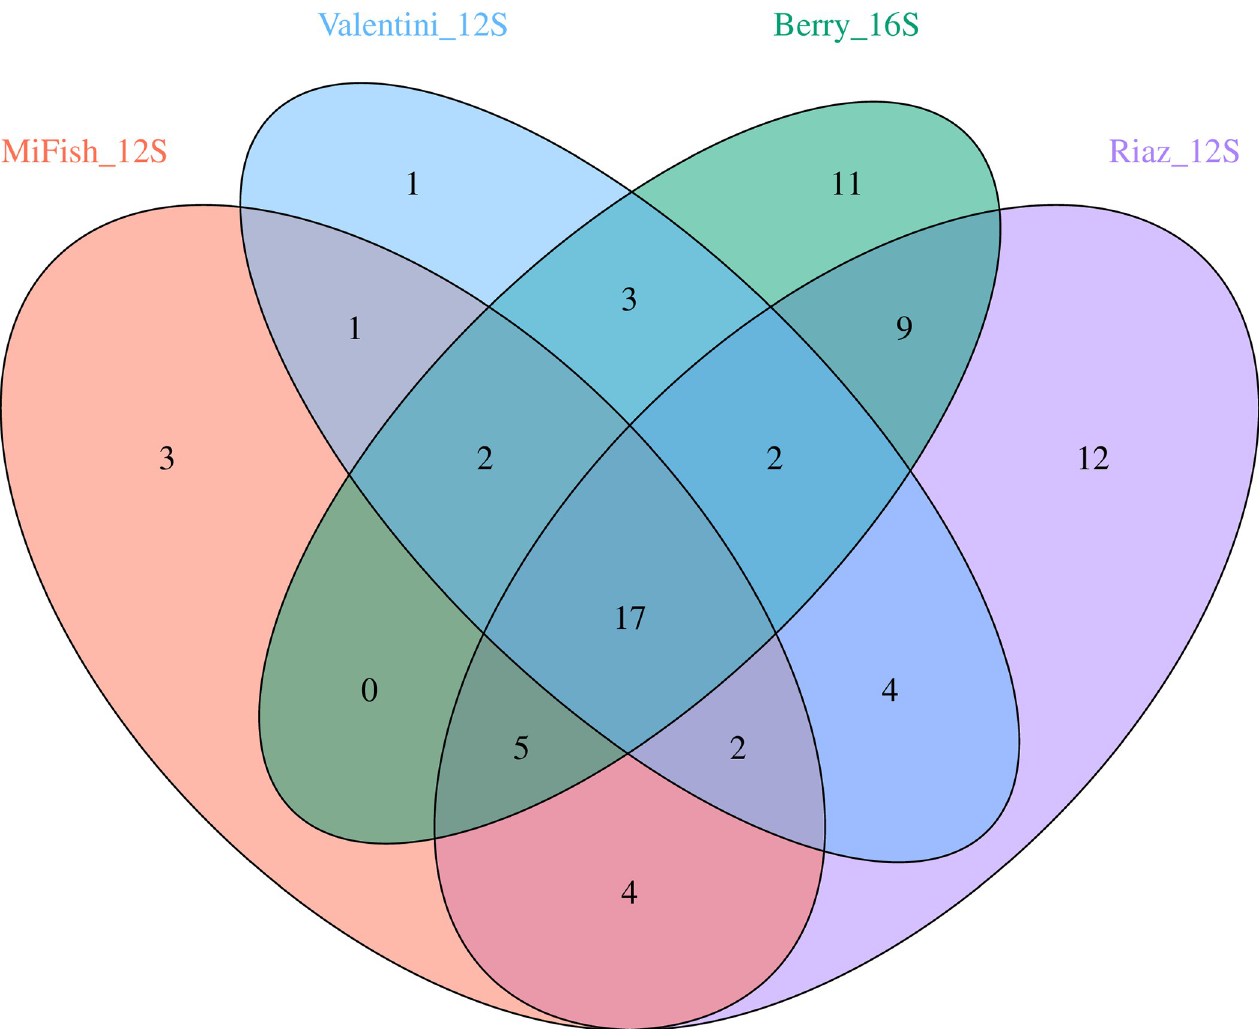
Fig 2. Venn diagram representing the number of fish species detected across four metabarcoding primer sets. The numbers shown in the areas of overlap reflect shared